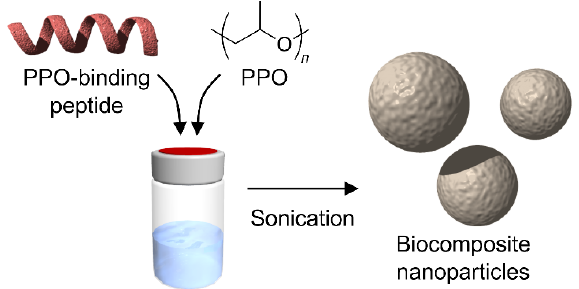
Figure 1. Schematic illustration of the preparation of biocomposite poly(propylene oxide) (PPO) nanoparticles with the PPO-binding peptide in an aqueous solution.